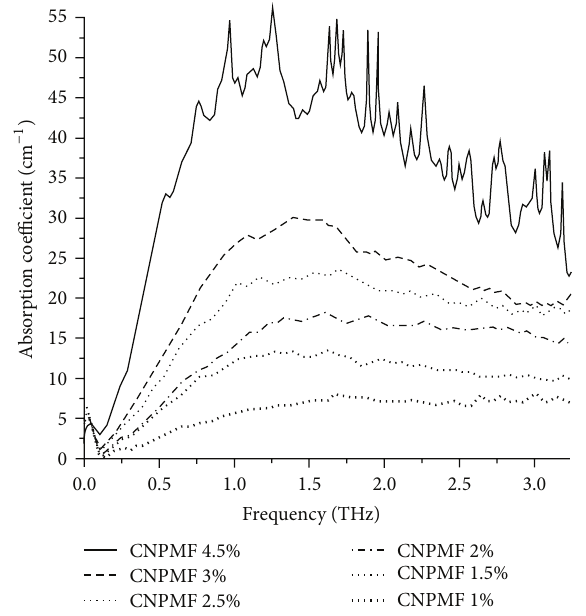
Figure 4: Carbon nanoporous microfibers absorption spectra changes with the increasing of their concentration in a plastic bag, % mass.